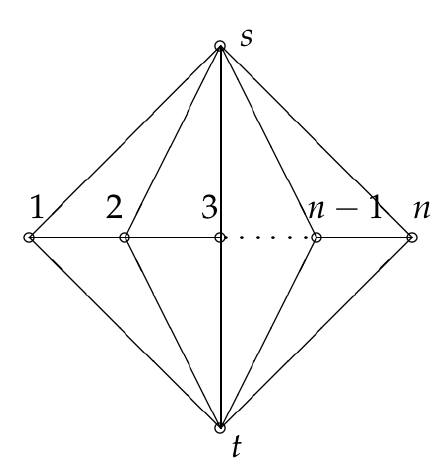
Figure 2. Graph DF n